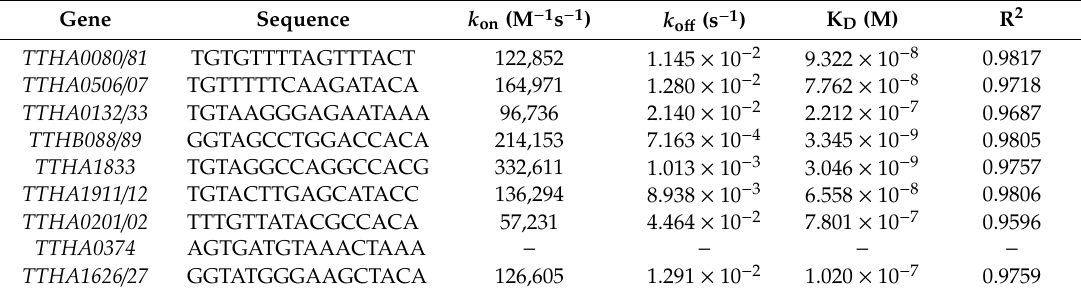
Table 3. Binding kinetics parameters of TTHB099 to potential gene promoter